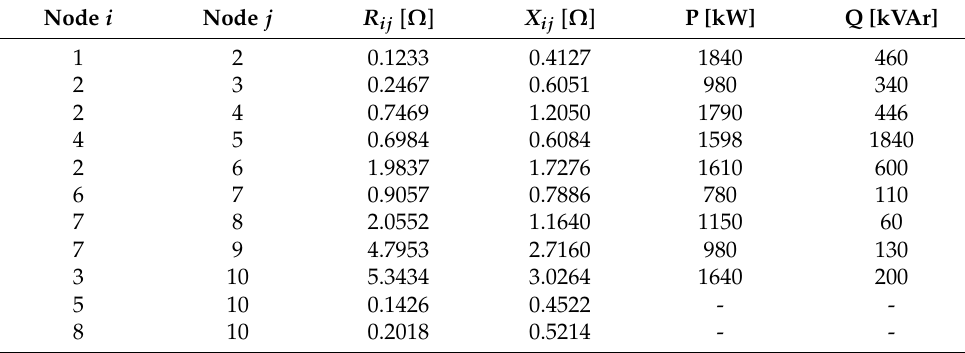
Figure 5. Electrical configuration of the 10-node mesh test system. Table 6. Electrical parameters of the 10-node mesh system.